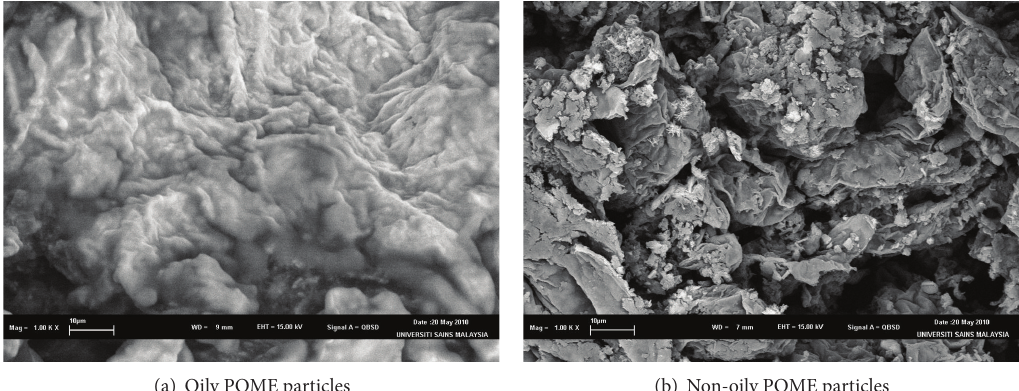
F 4: �EM images of (a) oily and (b) non-oily POME particles at 1000�